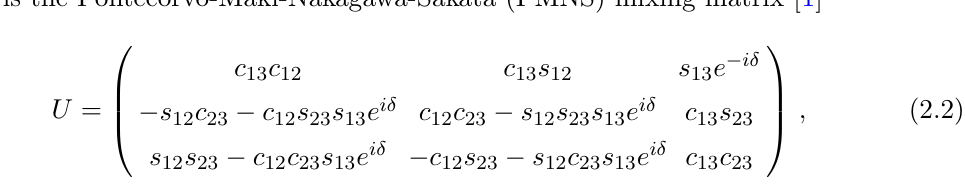
Table 1. 2 (cid:27) allowed ranges for the diagonal NSI parameters from the global analysis of current neutrino oscillation data [24], and from a simulation of DUNE and T2HK. where U is the Pontecorvo-Maki-Nakagawa-Sakata (PMNS) mixing matrix